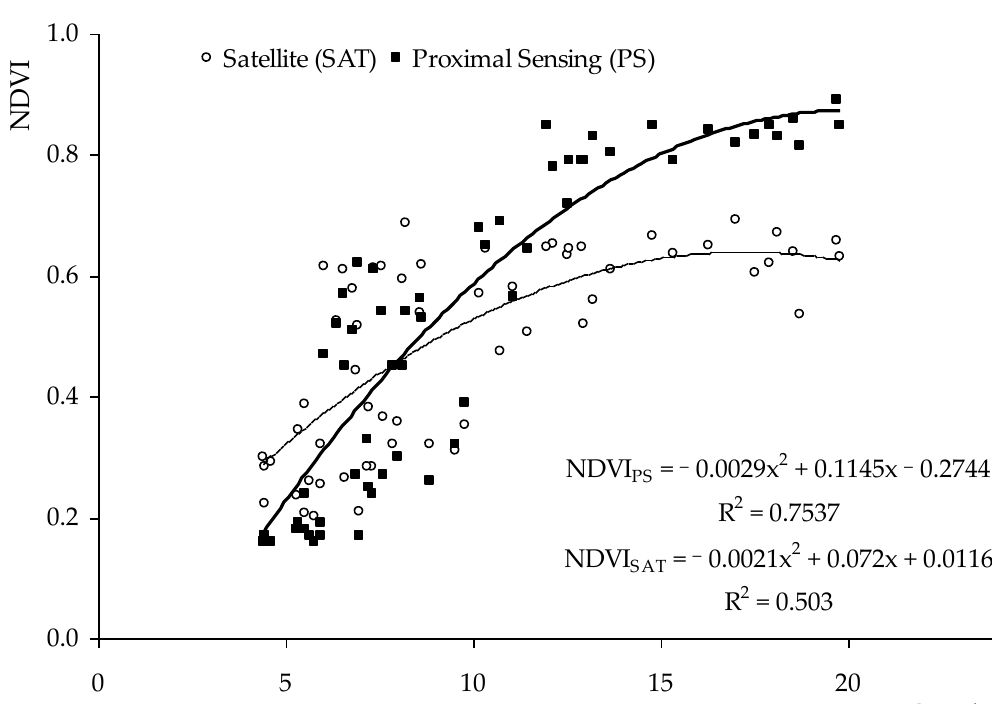
Figure 11. Correlation between vegetation index values (obtained by proximal sensor, NDVI PS ; and by satellite, NDVI SAT ) and pasture crude protein (CP), in the set of monthly sampling dates (between February and June 2017).